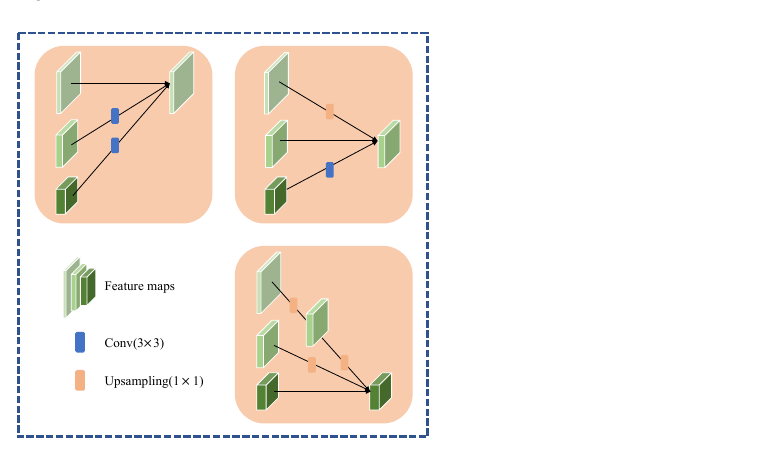
Figure 1. The structure of HRNet, the rectangular blocks represent the feature map, the color of the rect- angular blocks illustrates the different scale branches in HRNet, and ‘ → ’ refers to convolution operations.